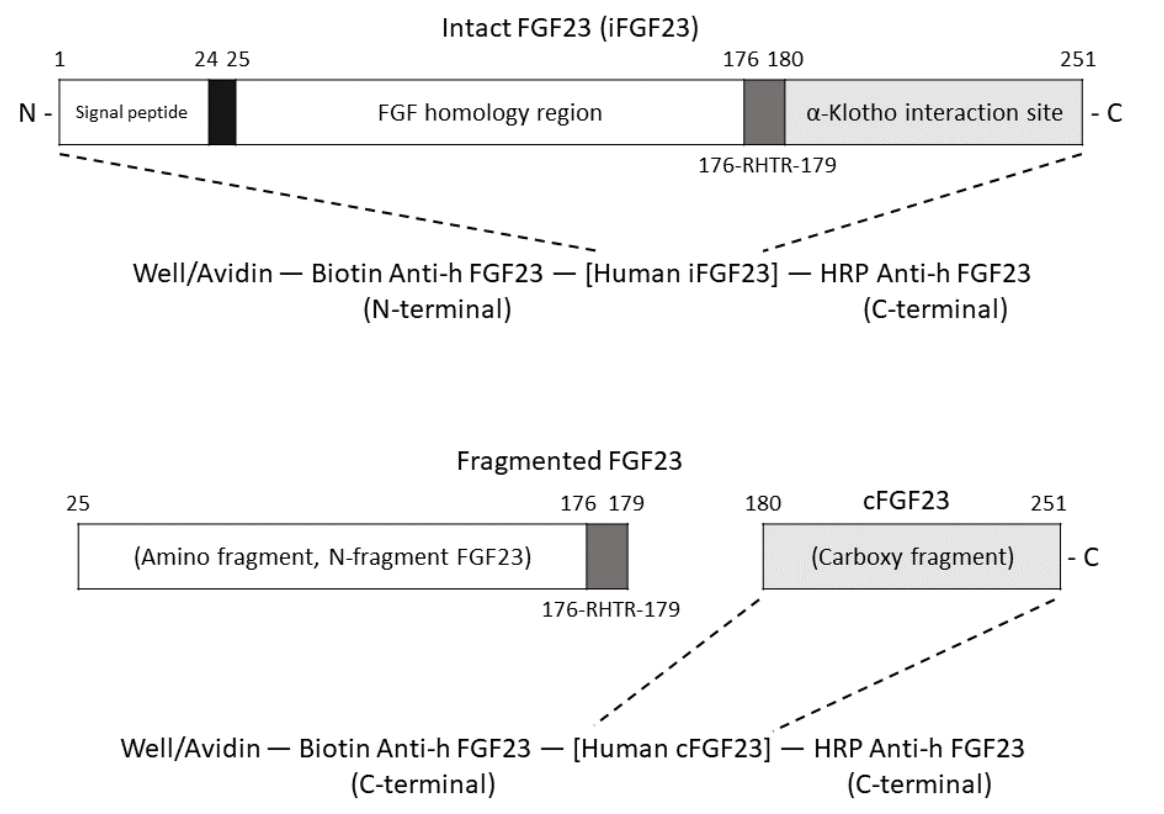
Figure 2. Mechanisms of iFGF23 and cFGF23 binding assays. Both iFGF23 and cFGF23 ELISA Kits are two-site enzyme-linked immunosorbent assays. Note that iFGF23 and cFGF23 are detected by two different affinity-purified goat polyclonal antibodies. One of them is biotinylated (Biotin Anti-h FGF23), able to bind with the epitopes from FGF23. The other antibody is conjugated with enzyme horseradish peroxidase (HRP Anti-h FGF23), playing a role in FGF23 detection. The biotinylated antibody, iFGF23/cFGF23 and HRP are formed into a “sandwich” complex.